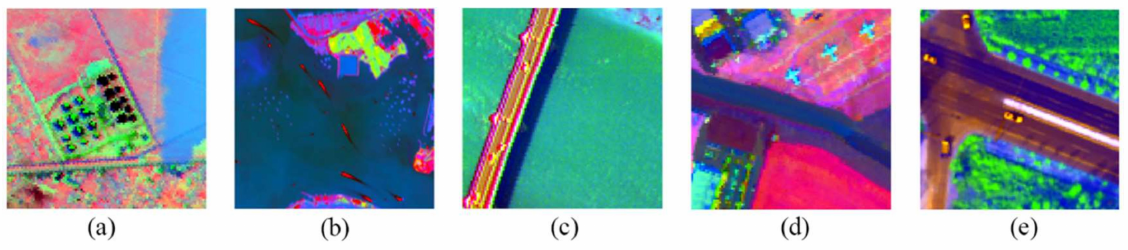
Figure 15. Color composite images of the first three principal components of the HSI images: ( a ) Texas Coast Image, ( b ) Belcher Bay Image, ( c ) PaviaC Image, ( d ) San Diego Image, and ( e ) Xiong’an